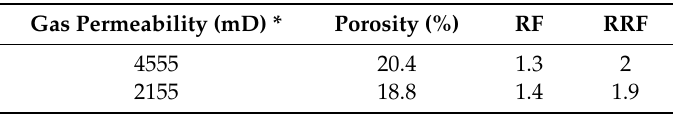
Table 1. Resistance factor or mobility reduction (RF) and residual resistance factor or permeability